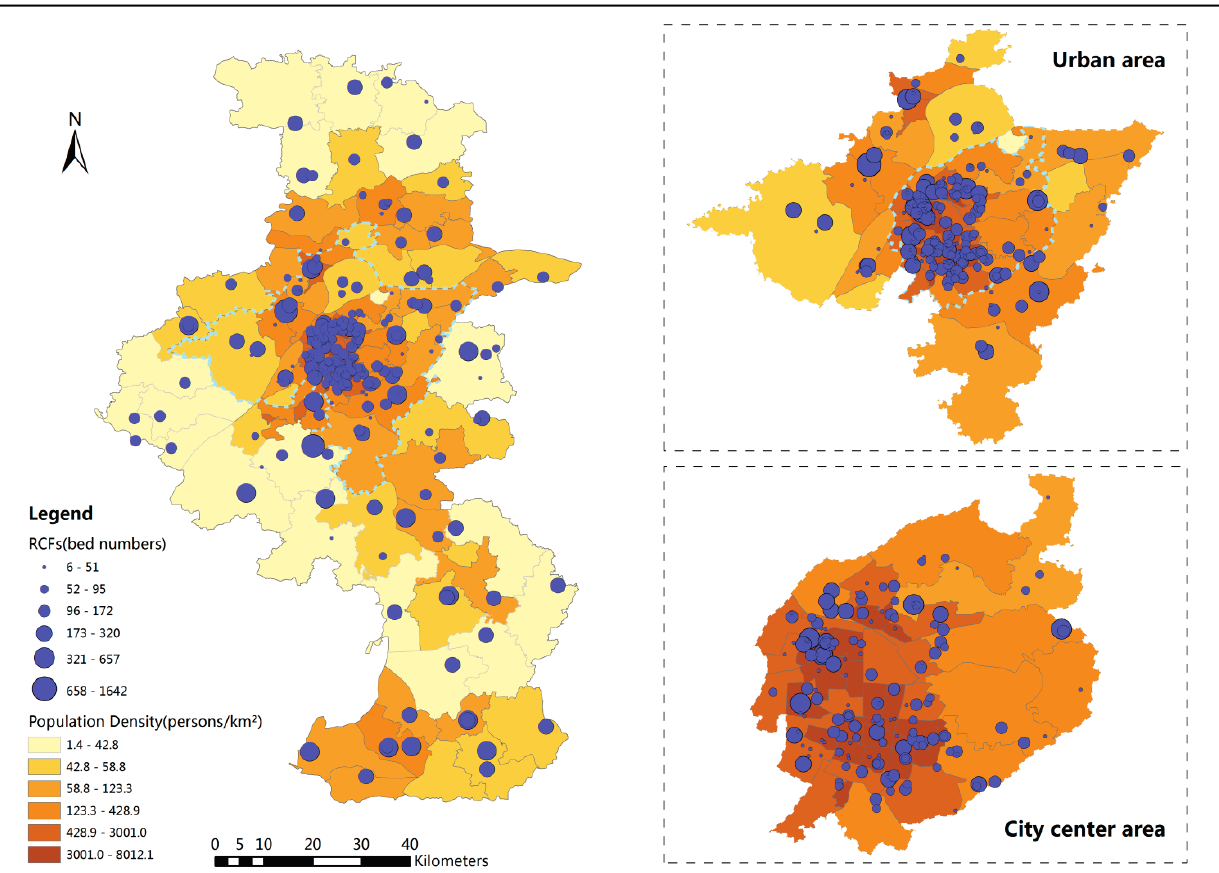
Figure 2. Residential care facility locations and elder population density in